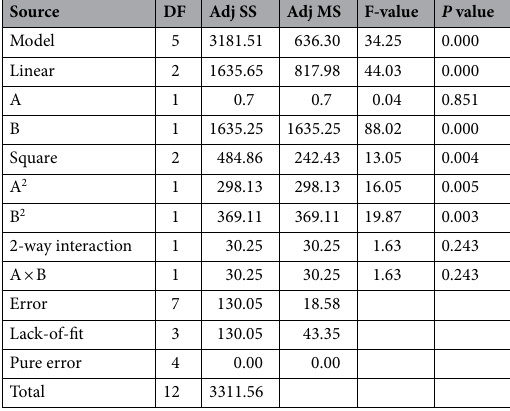
Table 4. Analysis of